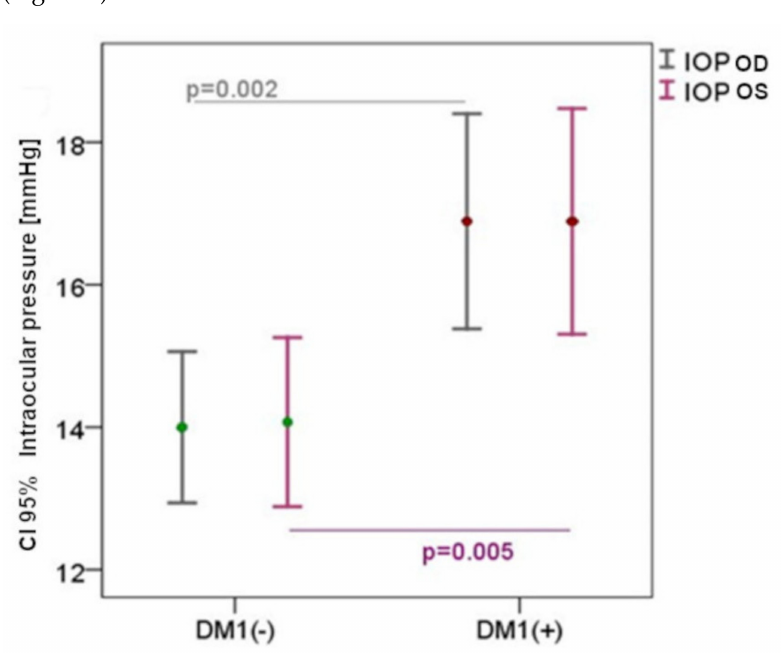
Figure 1. Left eye intraocular pressure (IOPos) and right eye intraocular pressure (IOPod) values in the DM1 group (DM1+) and the control group (DM1 − ), confidence interval (CI). By analysing morphological parameters, it can be seen that WLR and WT in the DM1 group are statistically significantly higher compared to the control group (Figure 2). Furthermore, tendentially higher WCSA values were found in the DM1 group (Table 3).